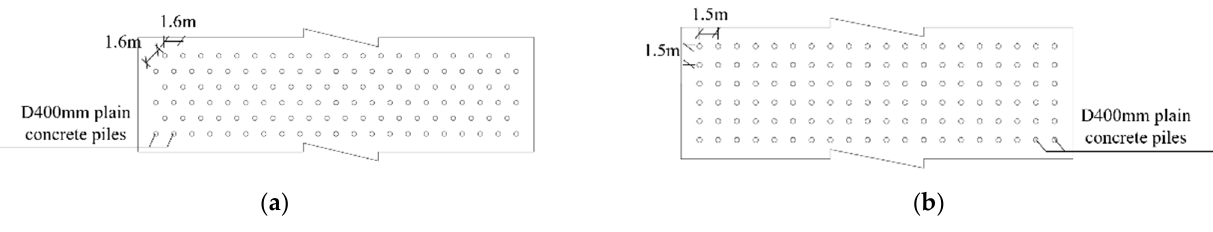
Figure 2. Top view of the standard section of the foundation. ( a ) Plum blossom pile ( b ) Square pile.